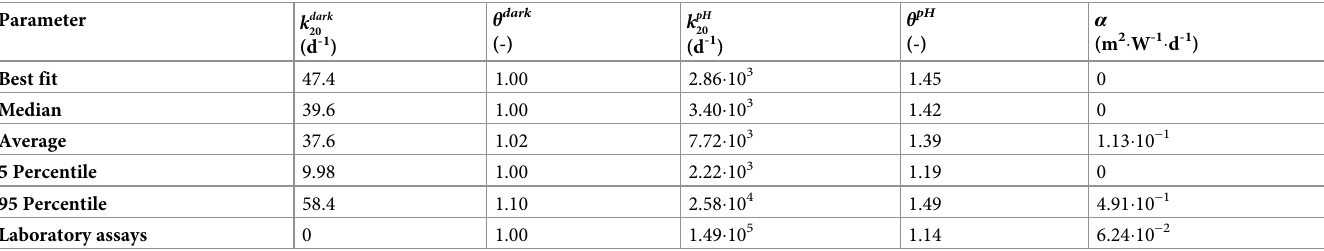
Table 3. Model parameters uncertainty estimated by Monte Carlo